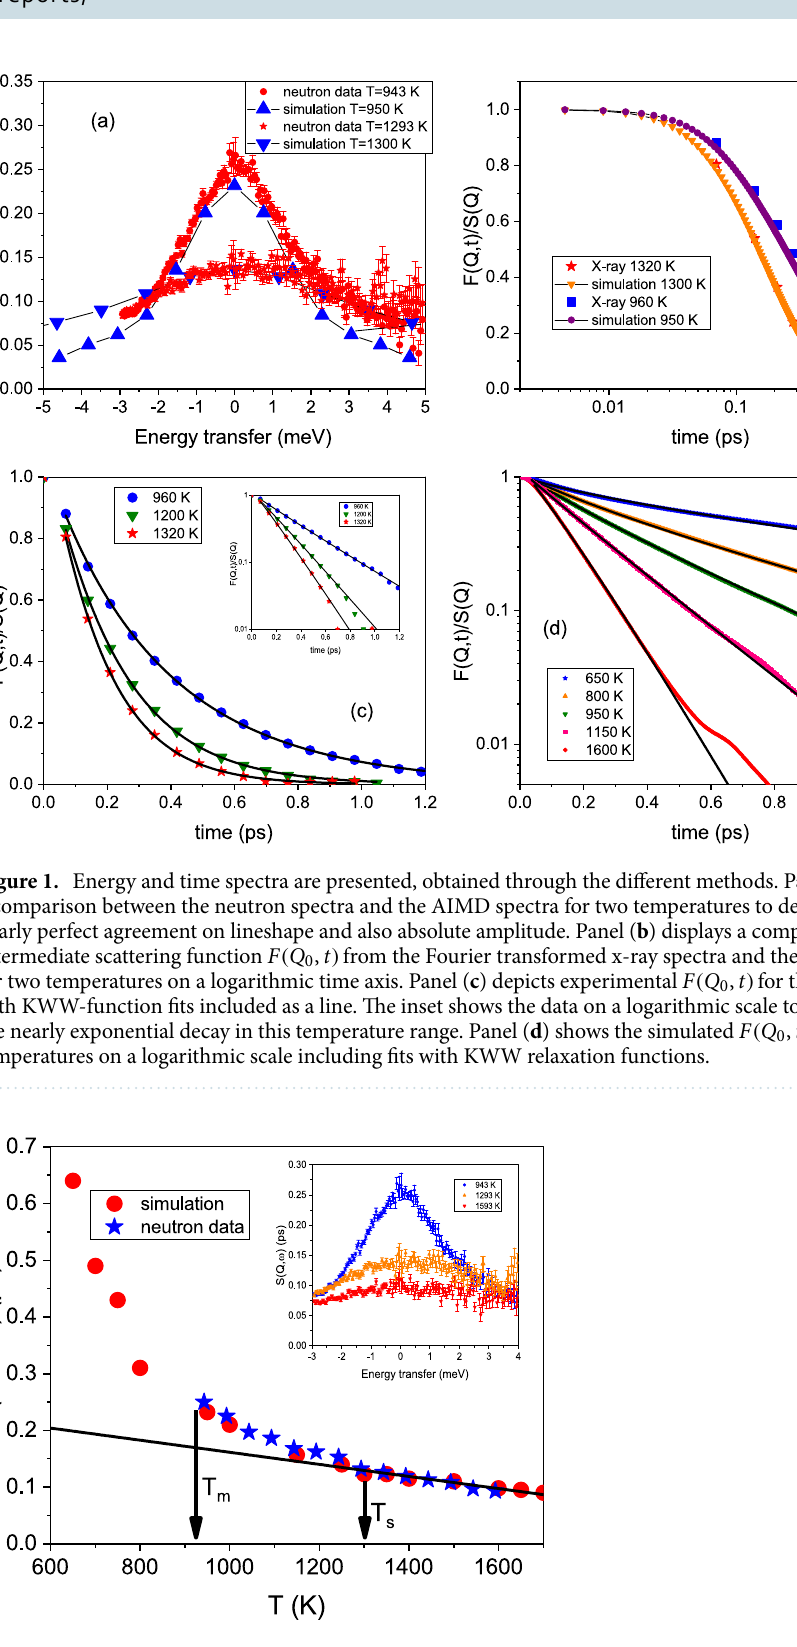
Figure 2. The amplitude S ( Q 0 , ω = 0 ) from the neutron data and the simulation is plotted and demonstrates a good quantitative agreement. The inset shows three neutron spectra, which demonstrate that the amplitude changes between 943 and 1293 K around 3 times faster than for the higher temperature range. The line is a fit through the high temperature points as a guide for the eye, and evidences a slope change around 1300 K with a stronger increase in the amplitude S ( Q , ω = 0 ) . Arrows indicate the melting temperature T m , and the stability limit of solid Al (see